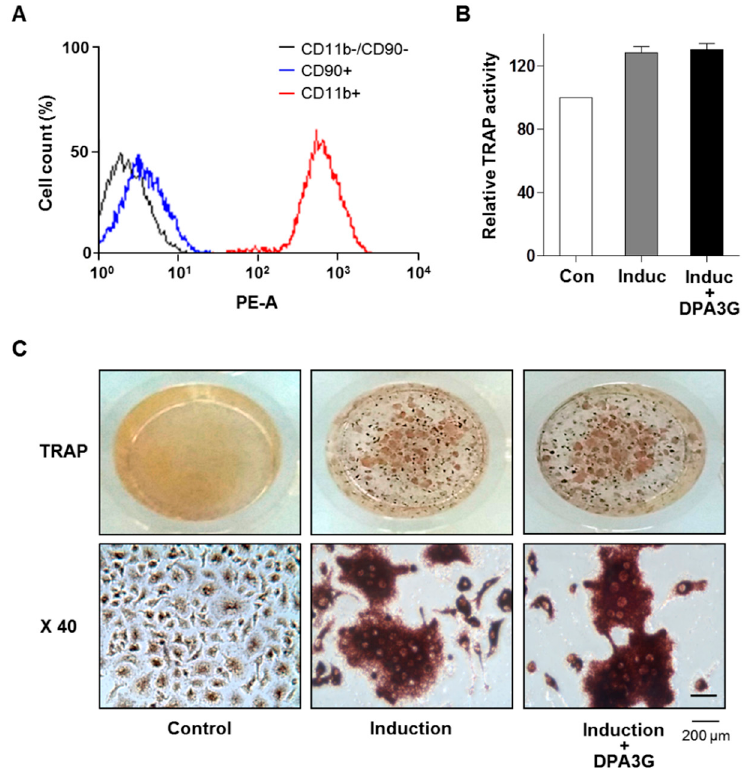
Figure 4. Effects of (1 ′ R ,2 ′ S ,5 ′ R ,8 ′ S ,2 ′ Z ,4 ′ E )-dihydrophaseic acid 3 ′ - O - β - D -glucopyranoside (DPA3G) on osteoclast differentiation of primary-cultured monocytes. ( A ) Validation of successful isolation of monocytes from mouse bone